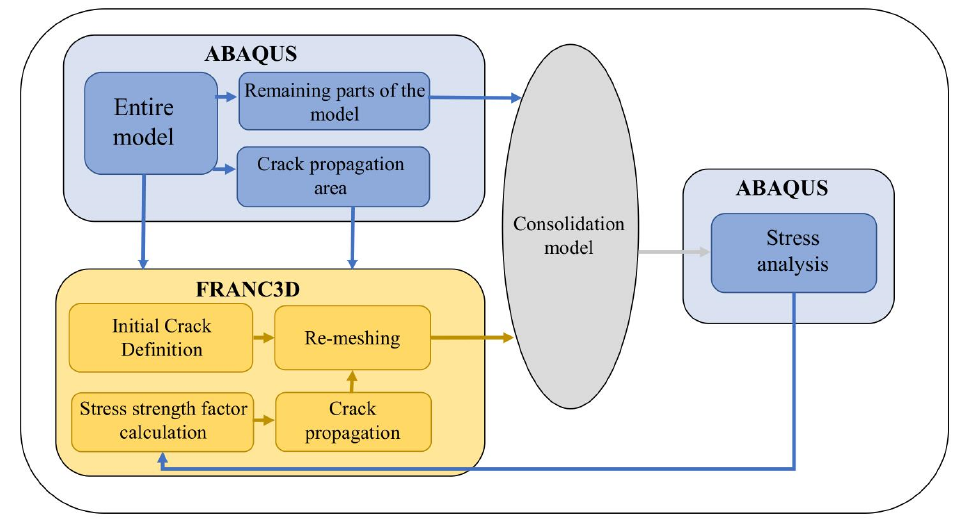
Figure 14. Fatigue crack propagation analysis.